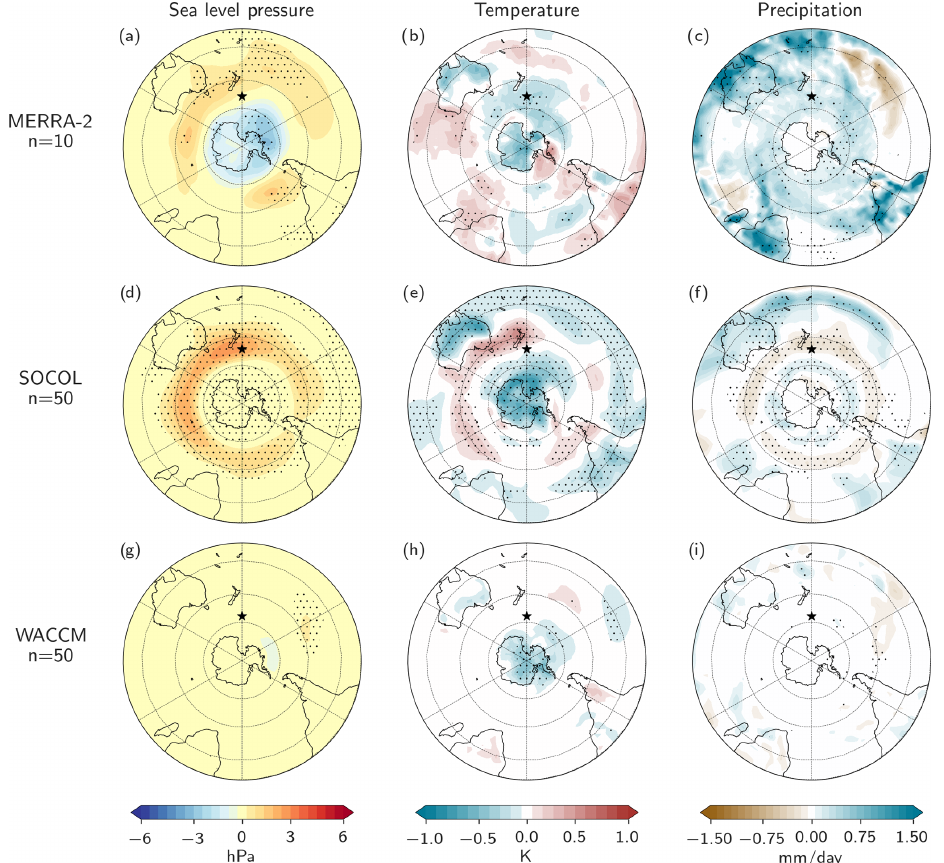
Figure A4. Surface climate composites for strong polar vortex regimes for October–January SLP anomalies (a, d, g) , 2m temperature anomalies (b, e, h) , and precipitation anomalies (c, f, i) . The reanalysis data MERRA-2 (a–c) includes 10 weak vortex regimes, and the CCMs SOCOL (d–f) and WACCM (g–i) each include 50 weak vortex regimes. Stippling refers to significance at the 4.5% level assessed with a bootstrapping test.